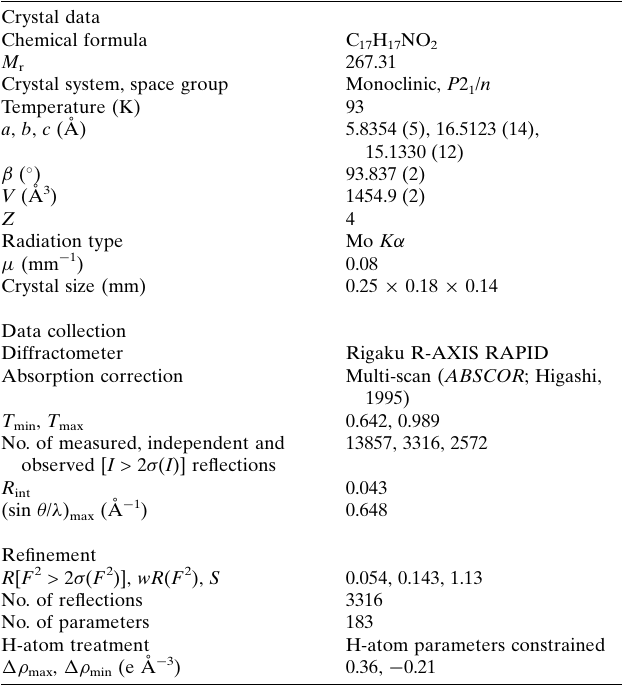
Table 2 Experimental details. Crystal data Chemical